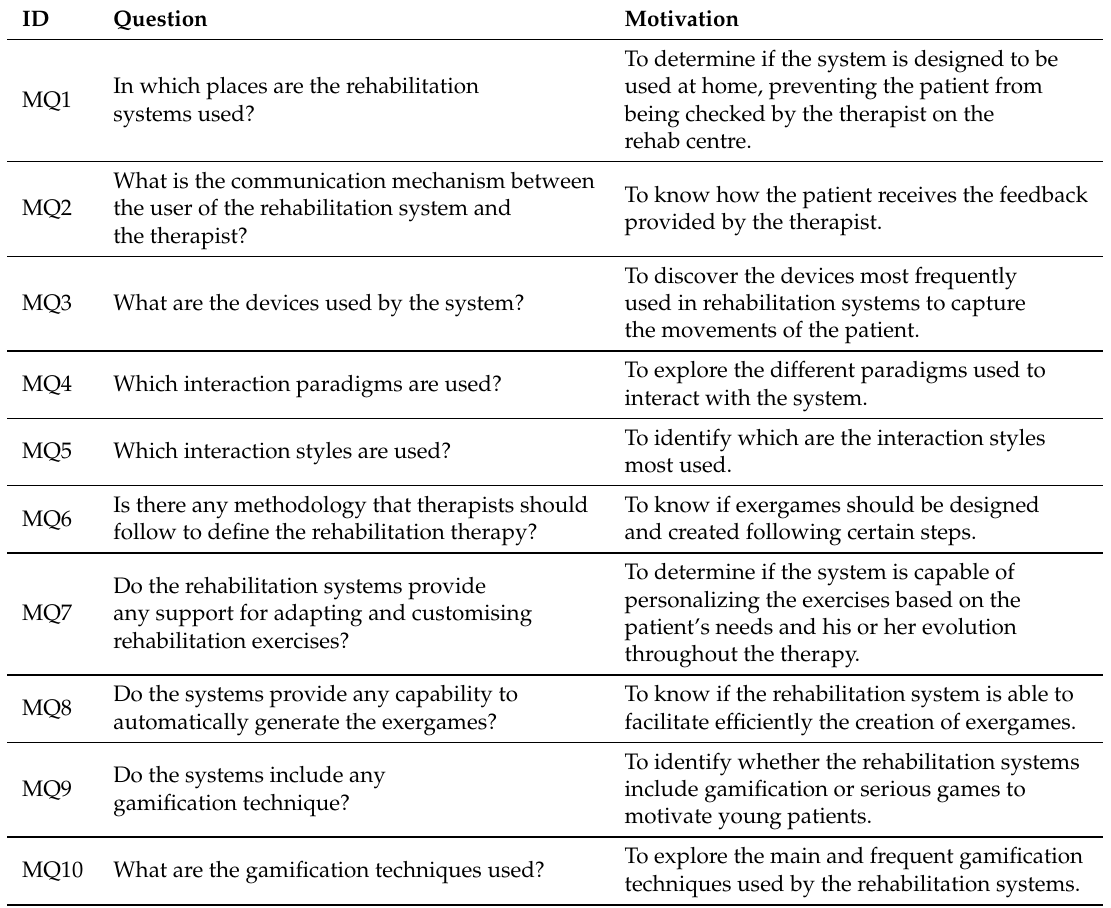
Table 1. Mapping questions and their